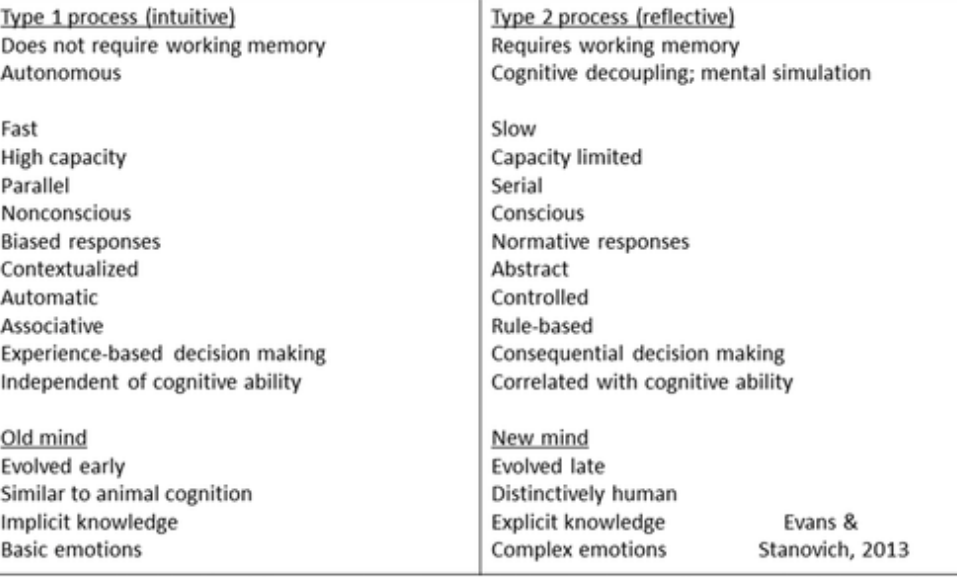
Figure 2. Dual process theory of cognition. Fast Type 1 processing generates intuitive default responses on which subsequent reflective Type 2 processing may or may not intervene (Evans and Stanovich 2013).